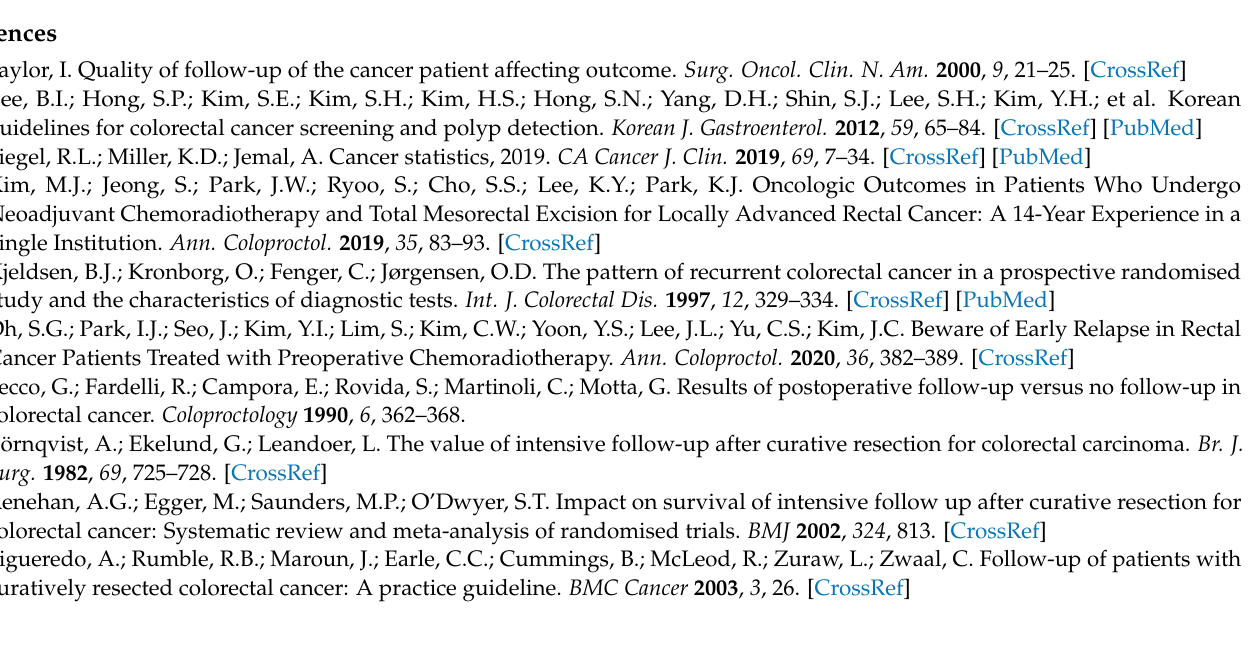
Table S2: Factors affecting recurrence-free survival according to the recurred site, Table S3: Factors affecting post-recurrence survival according to the recurred site, Table S4: Clinical characteristics of patients in the development and validation cohorts, Table S5: Predictors of recurrence after radical resection, Table S6: Demographic and clinical characteristics of patients with high recurrence risk ( N =